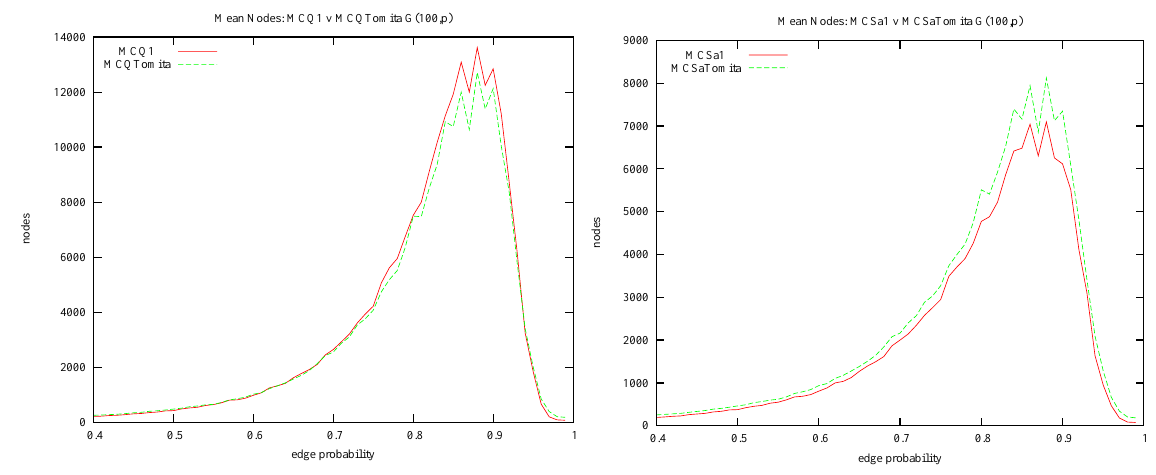
Figure 11. The effect of Tomita’s initial colour